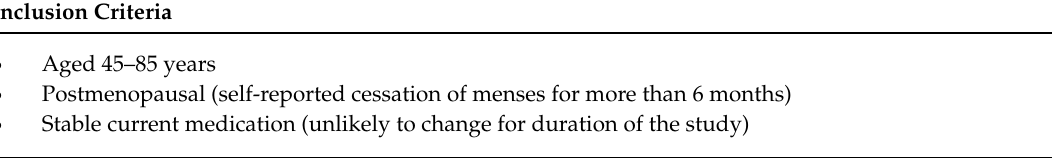
Table 1. Eligibility criteria for the